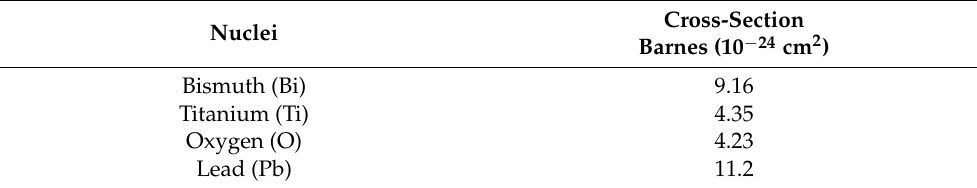
Table 3. Cross-sections of